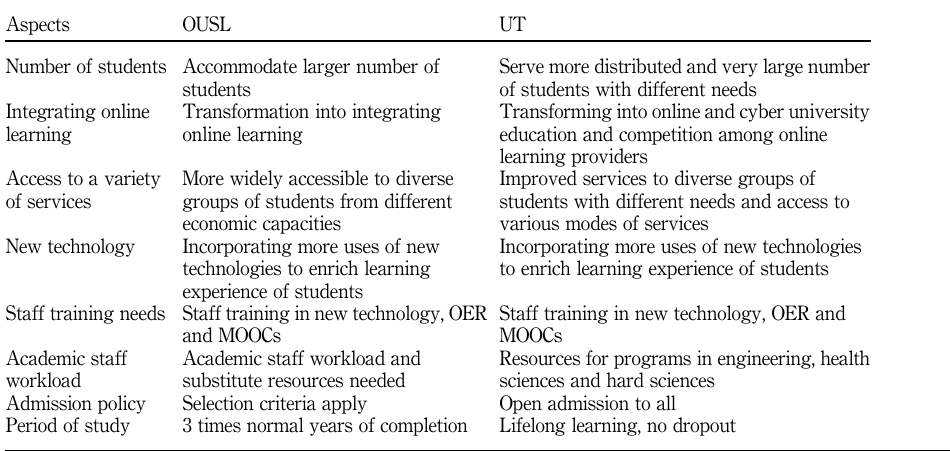
Table 2. Challenges